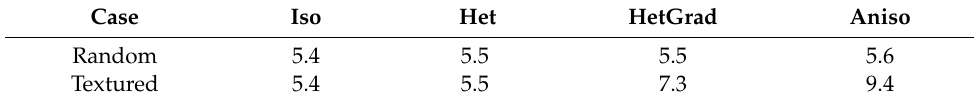
Table 1. CPU time in hours of the four formulations with heterogeneous GB energy and